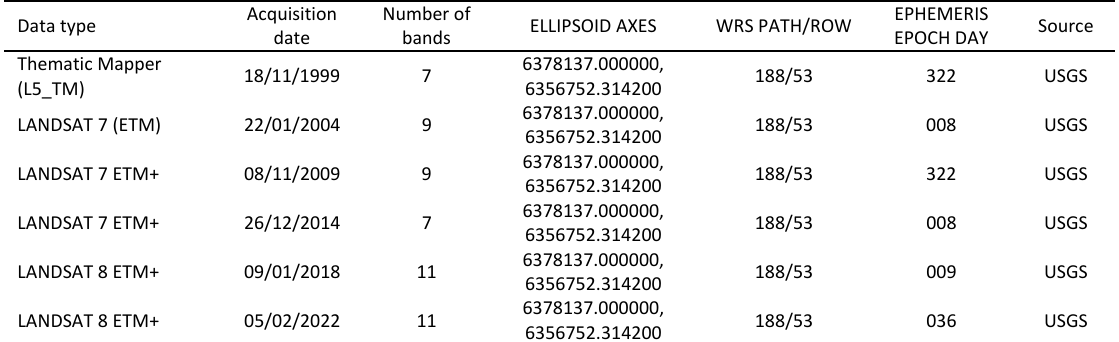
Table 1: Data type and sources